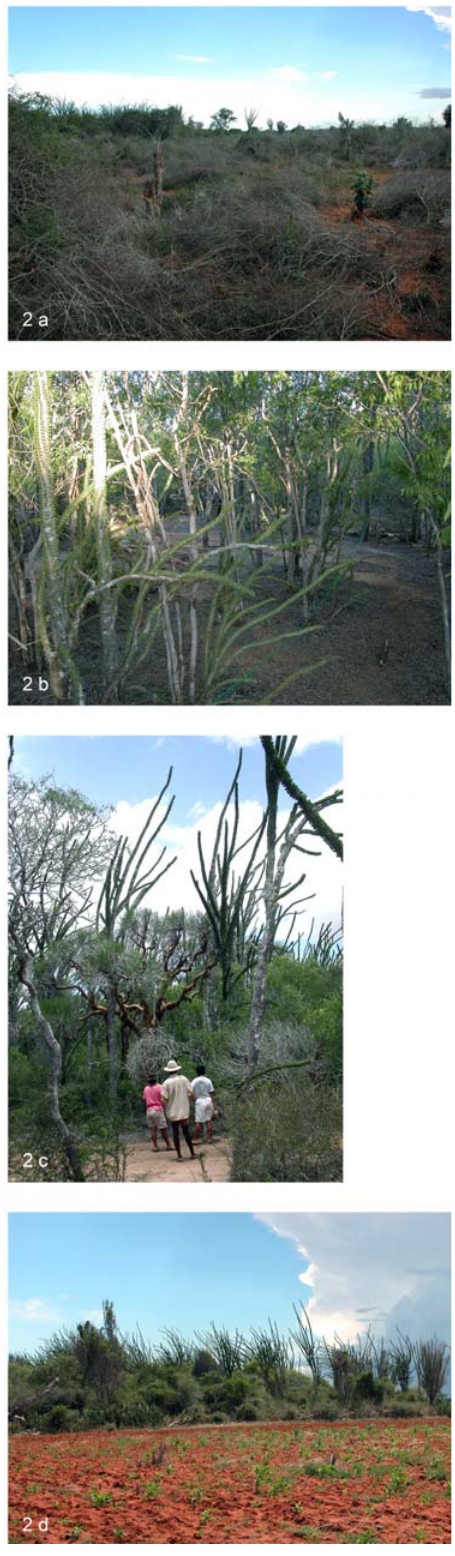
Figure 2. Pictures from the four surveyed areas a) degraded/thinned forest (Area I), b) regenerating forest (Area II), c) stable forest (Area III), d) forest patch protected by local taboos (Area IV). Pictures taken in January 2005.